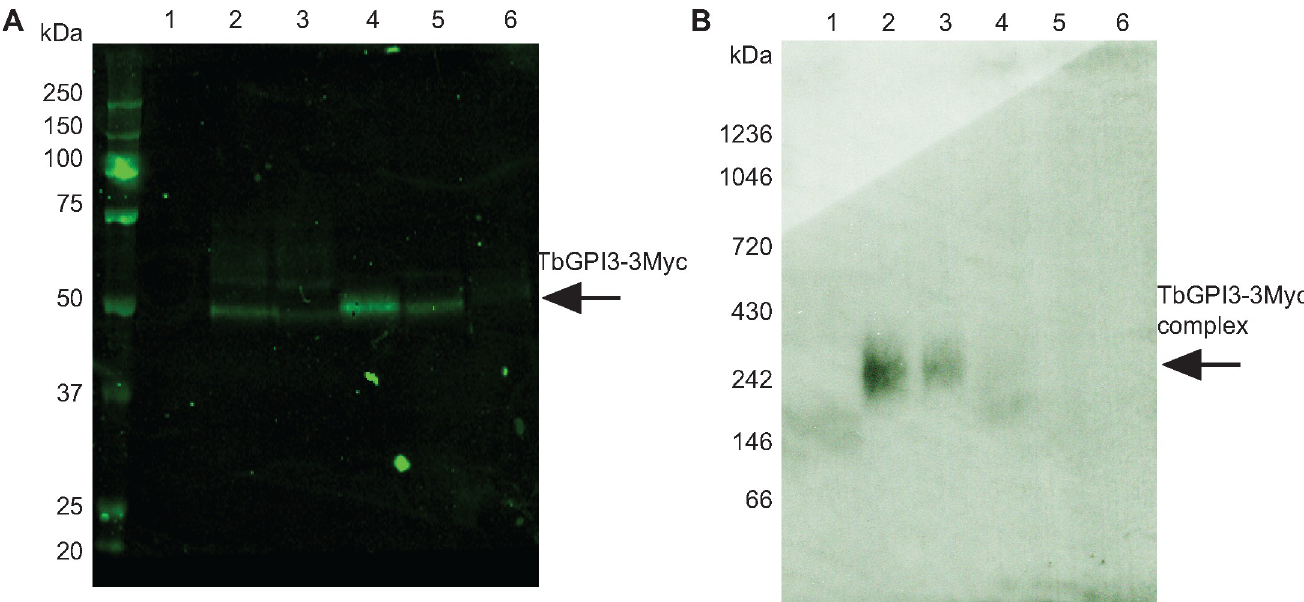
Fig 2. TbGPI3-3Myc is present in complexes in BSF T . brucei . (A) Aliquots of 2 × 10 8 cells were harvested and lysed in lysis buffer containing different detergents to assess TbGPI3-3Myc solubilisation. After immunoprecipitation of the supernatants with anti-Myc agarose beads, proteins were eluted with 0.5 mg/mL c-Myc peptide and aliquots were subjected to SDS-PAGE followed by anti-Myc Western blotting. (B) Identical samples were also separated by native-PAGE and subjected to anti-Myc Western blotting. In both cases, lane 1 corresponds to wild type cells lysed with 1% TX-100, as a negative control for anti-Myc blotting, and lanes 2–6 correspond to TbGPI3-3Myc clone1 lysed with 0.5% digitonin, 1% digitonin, 1% TX-100, 1% NOG or 1% DM, respectively.